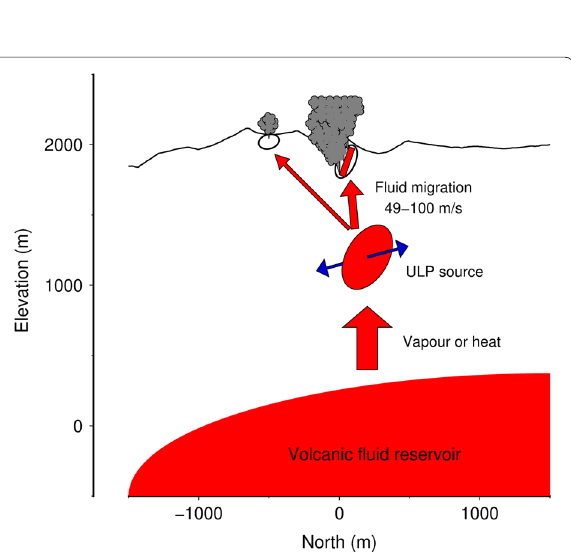
Fig. 17 Schematic model of the source process of the ULP event at the Mount Motoshirane volcano inferred from the results of the waveform